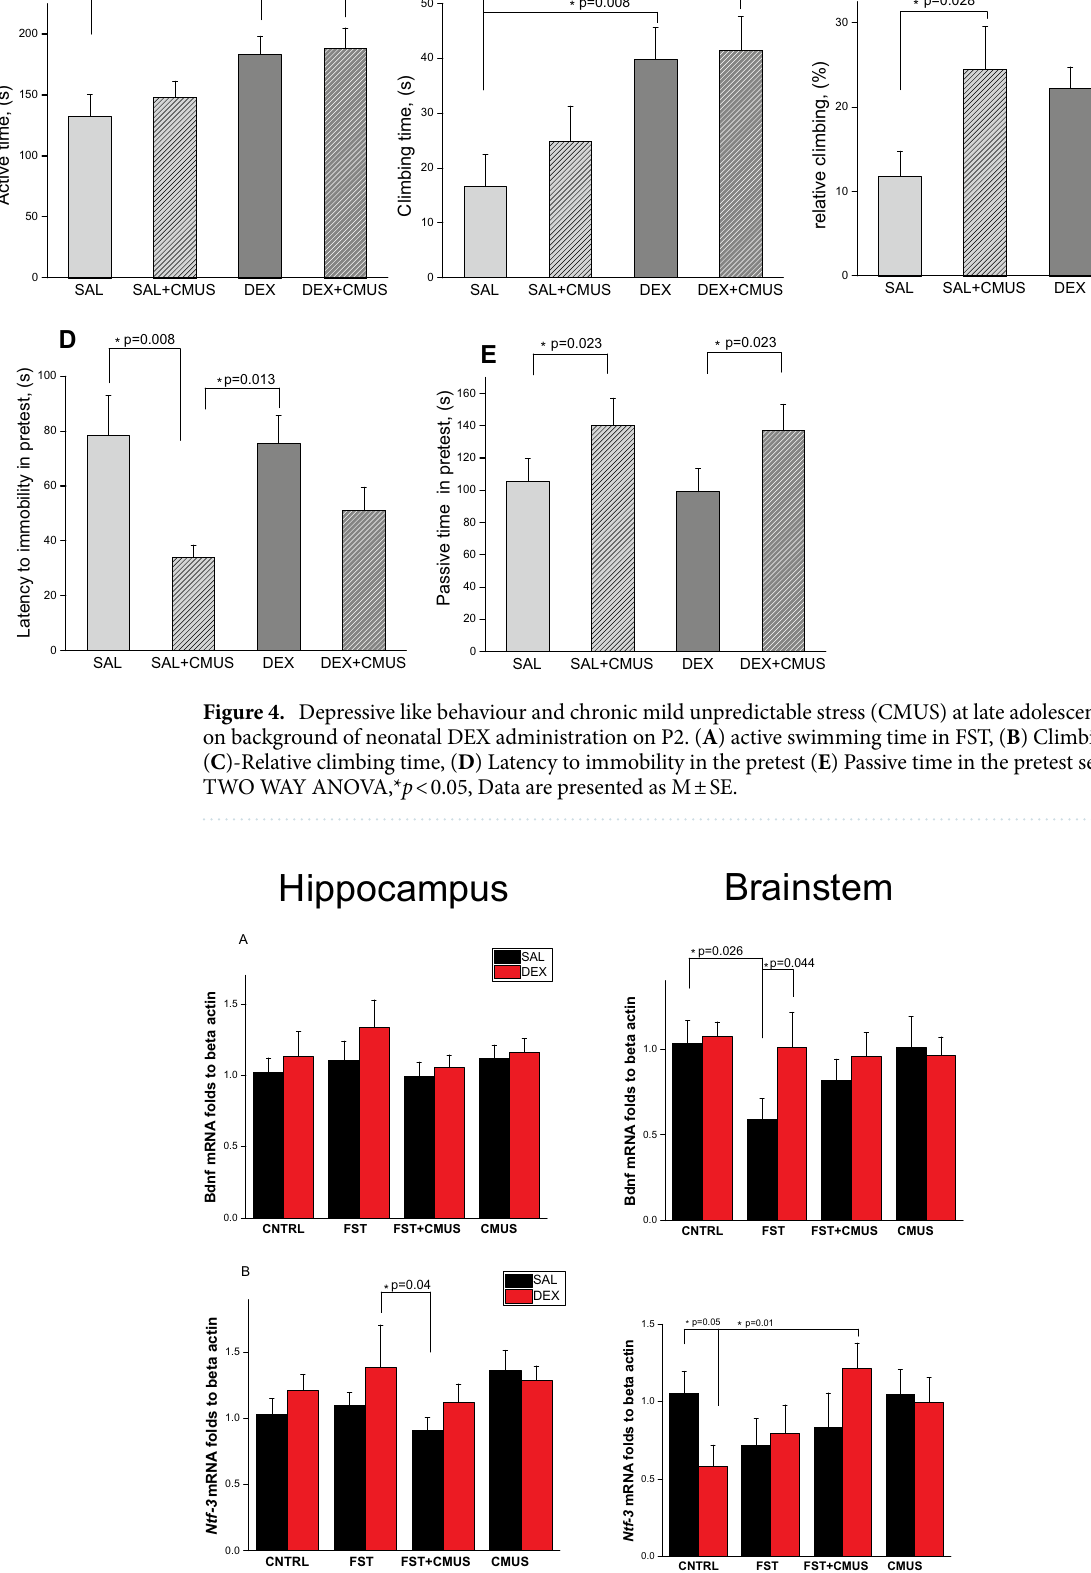
0.0 CNTRL FST FST+CMUS CMUS